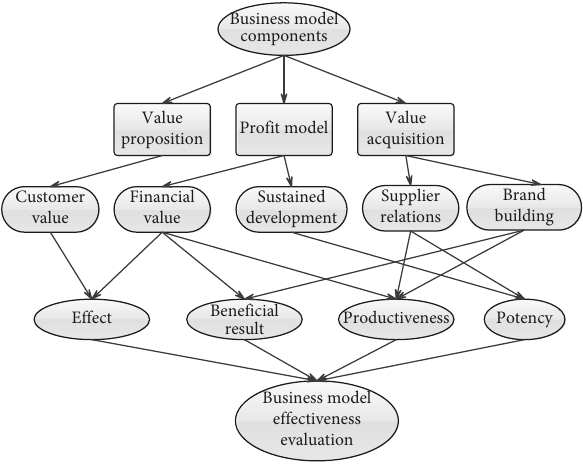
Figure 6: The relationship between the components of the tech- nological startups business model and the effectiveness evaluation of the technological startups business